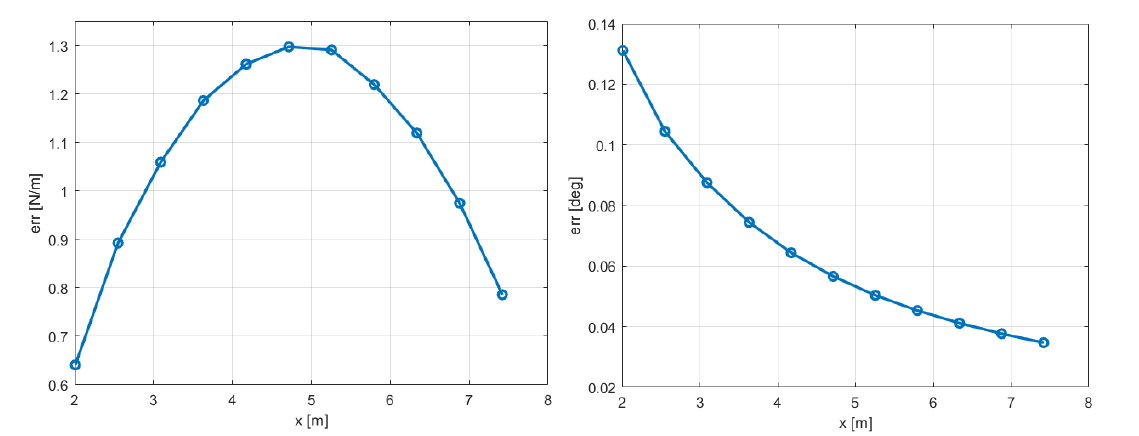
Figure 11. Absolute error of distributed lift and angle of attack—reference data in Figure